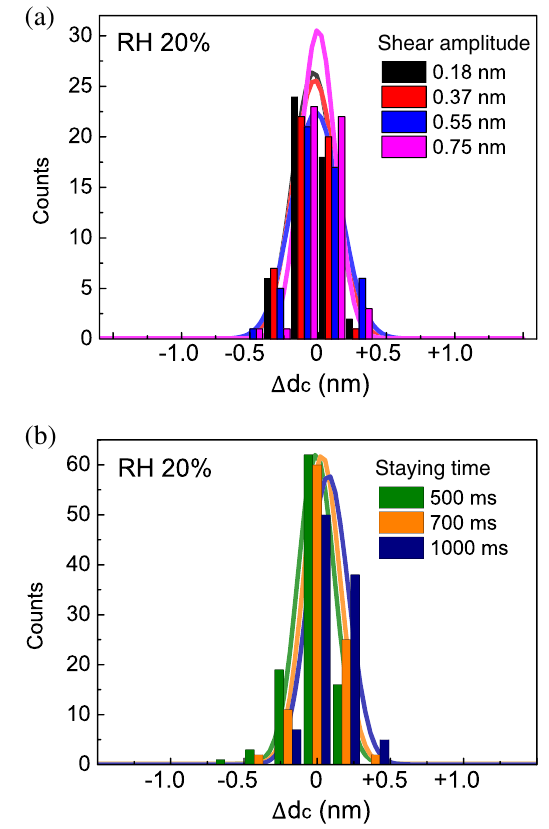
FIG. 7. (a) 50-times approach-retraction processes were con- ducted at differing shear amplitudes. (b) Similarly, 100-times processes were performed at various τ s . The histogram shows that d does not depend on the amplitude nor approach the velocity c ( ¼ 0 . 05 nm = τ s ) within the available